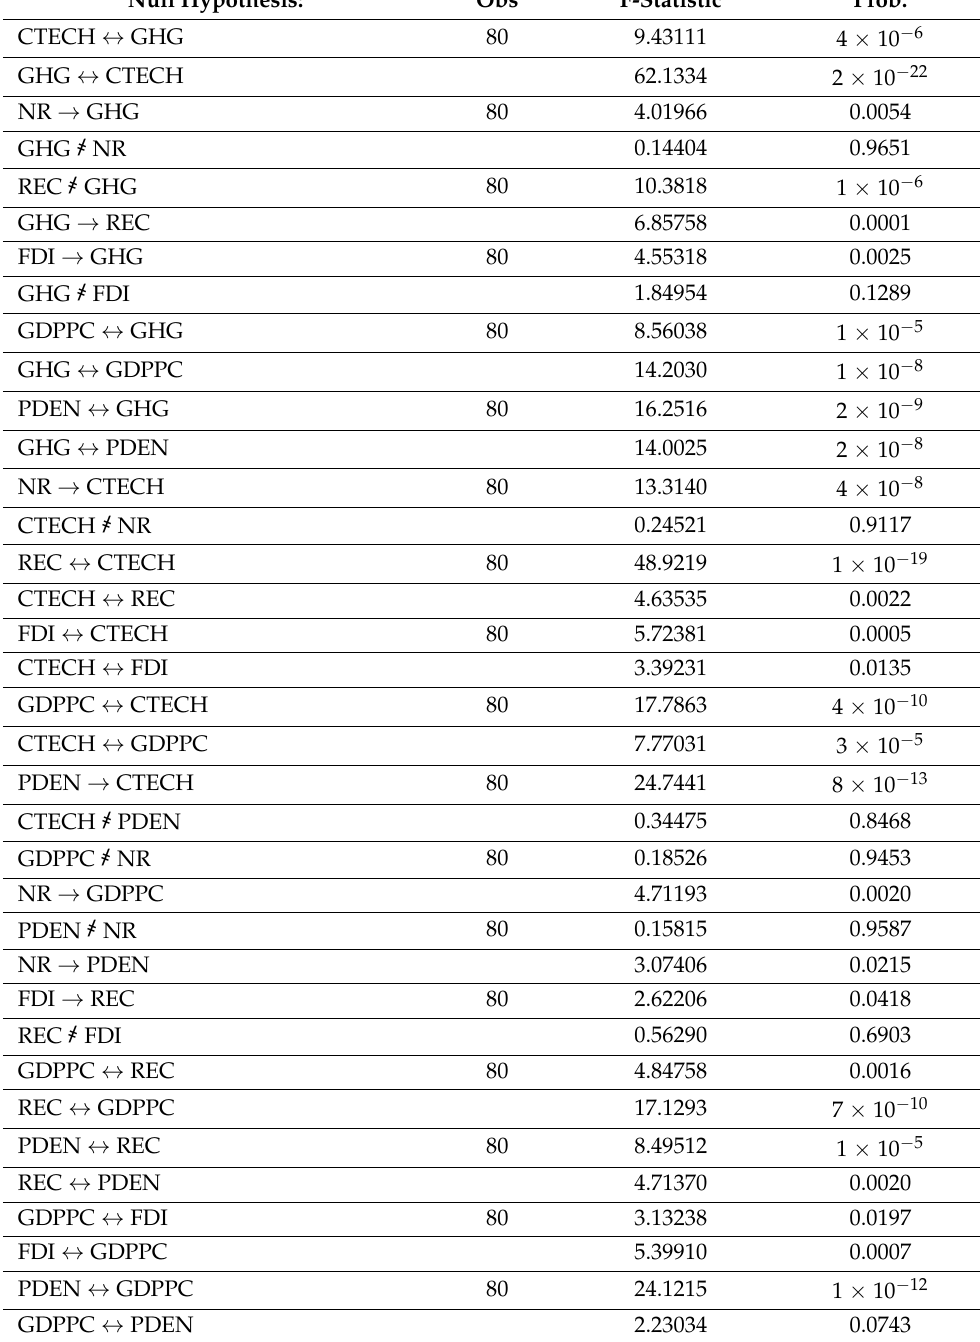
Table 5. Granger Causality Estimates.